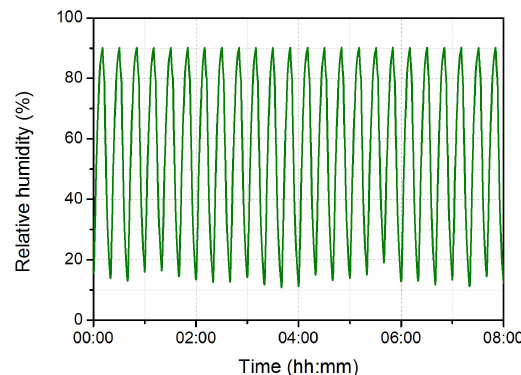
Figure 2. Experimental data showing the relatively fast RH control of the humidifier system. A full RH cycle, when the RH varied from 10% to 90% and back again, lasted about 20min. The RH was measured at the inlet of the optical